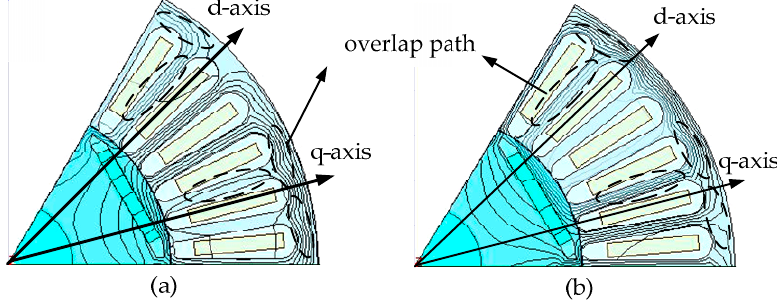
Figure 1. Results of magnet flux circuit with current while the Ψ f is set to 0 . ( a ) d -axis flux circuit when i q = 0; ( b ) q -axis magnet flux circuit when i d = 0.